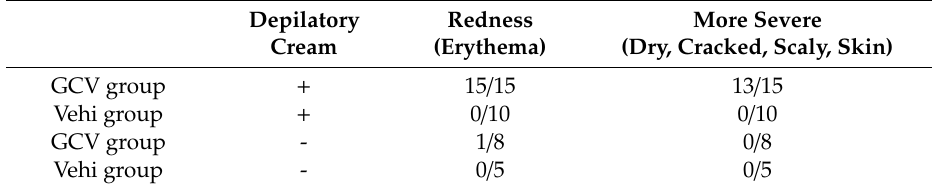
GCV group: GCV-treated rats. Vehi group: Vehicle-treated rats. The data represent the number of rats showing each symptom / the total number of